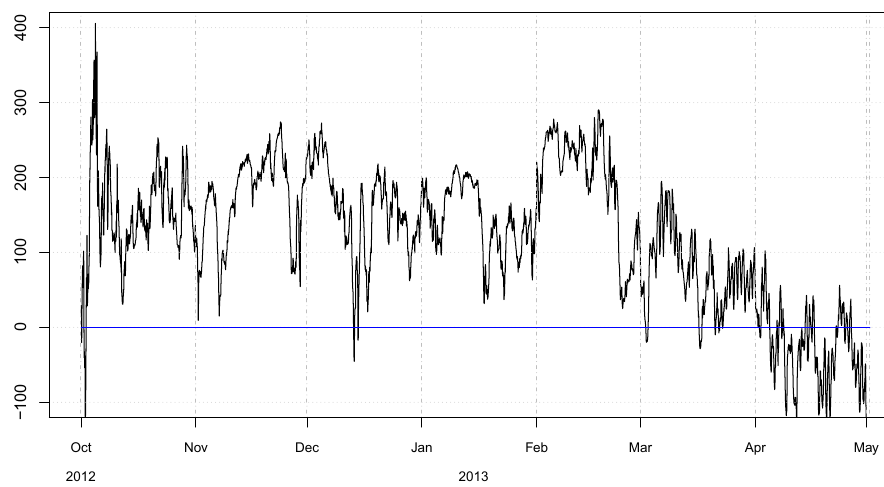
Figure C1. Temperature gradient between air and soil (5cm in depth) at the grass centre of the reference polygon.